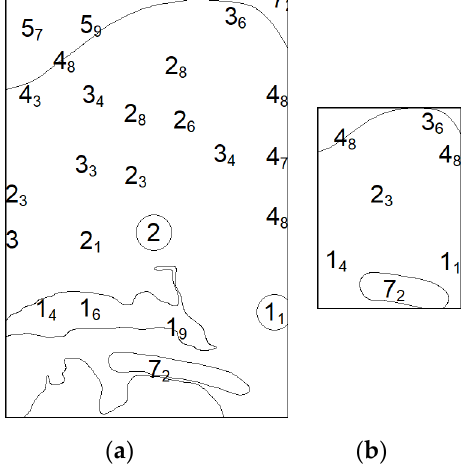
Figure 12. Extract ( a ) from the 1:40 K scale chart (depth contours 2, 5, 10 m) and ( b ) the 1:80 K scale chart (depth contours 5, 10 m).